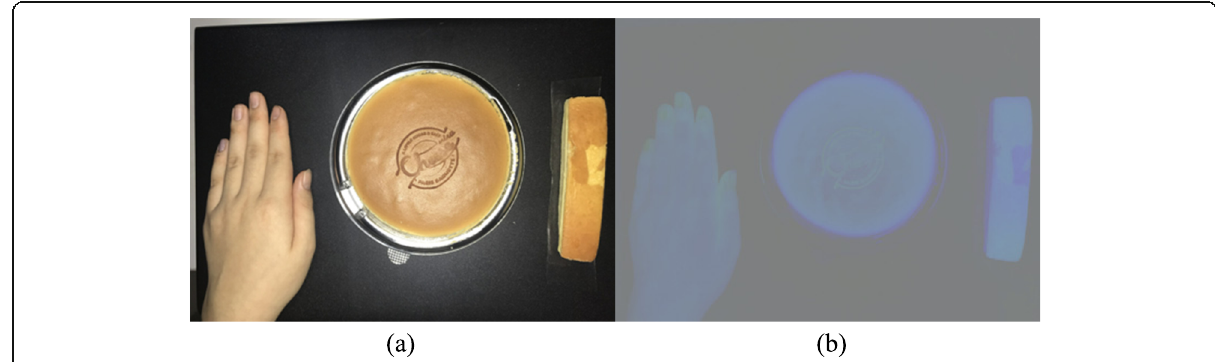
Fig. 2 Comparison before and after treatment. a The original image. b Transferred to L*a*b* color